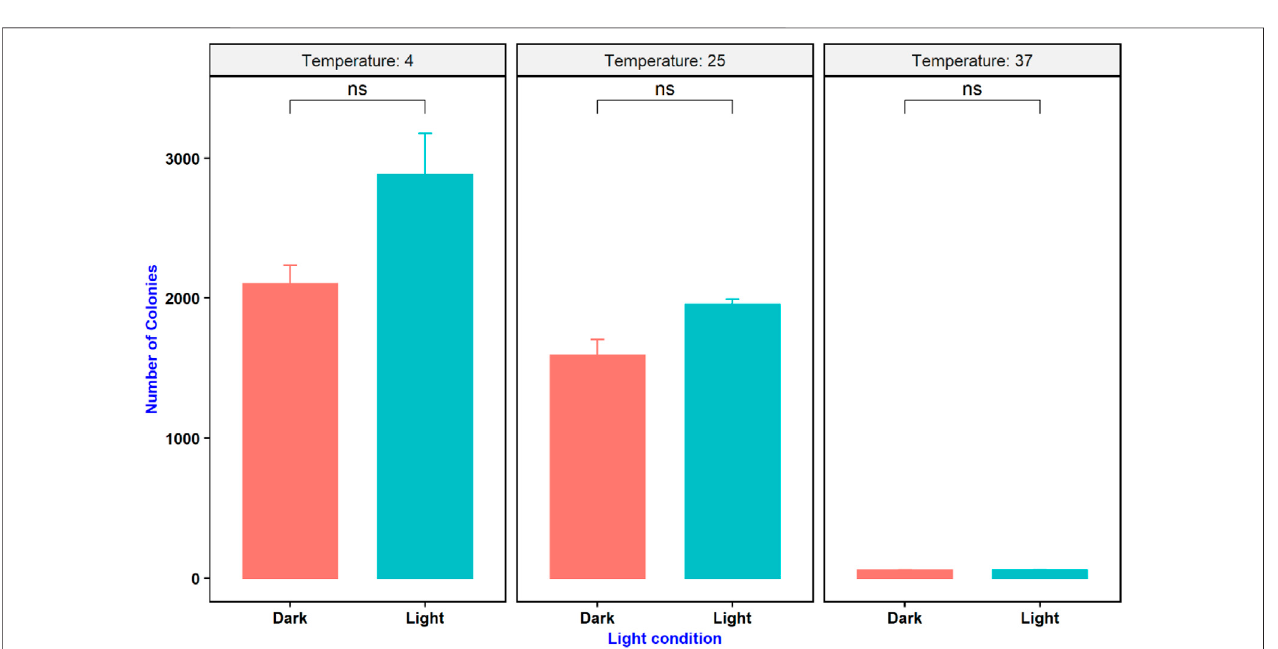
FIGURE 8 | Effect of temperature and light condition on gene delivery ability of COOH-CDs on E. coli cells.